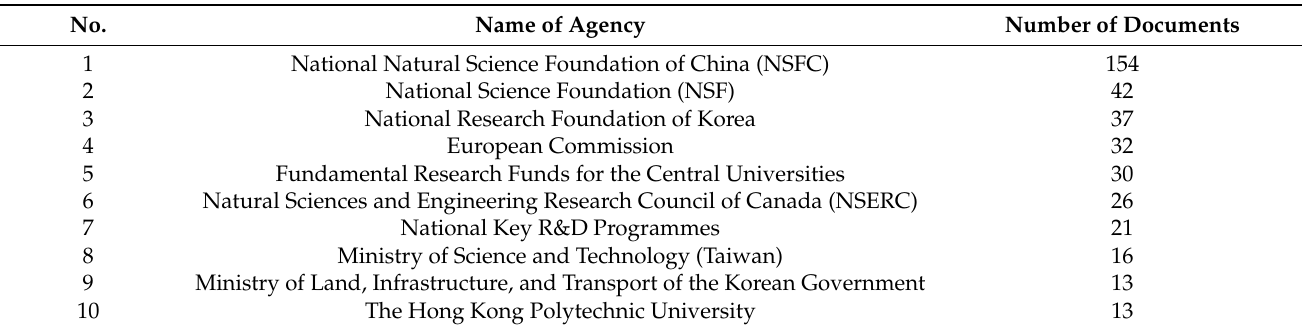
Table 3. Top 10 funding agencies in the world.